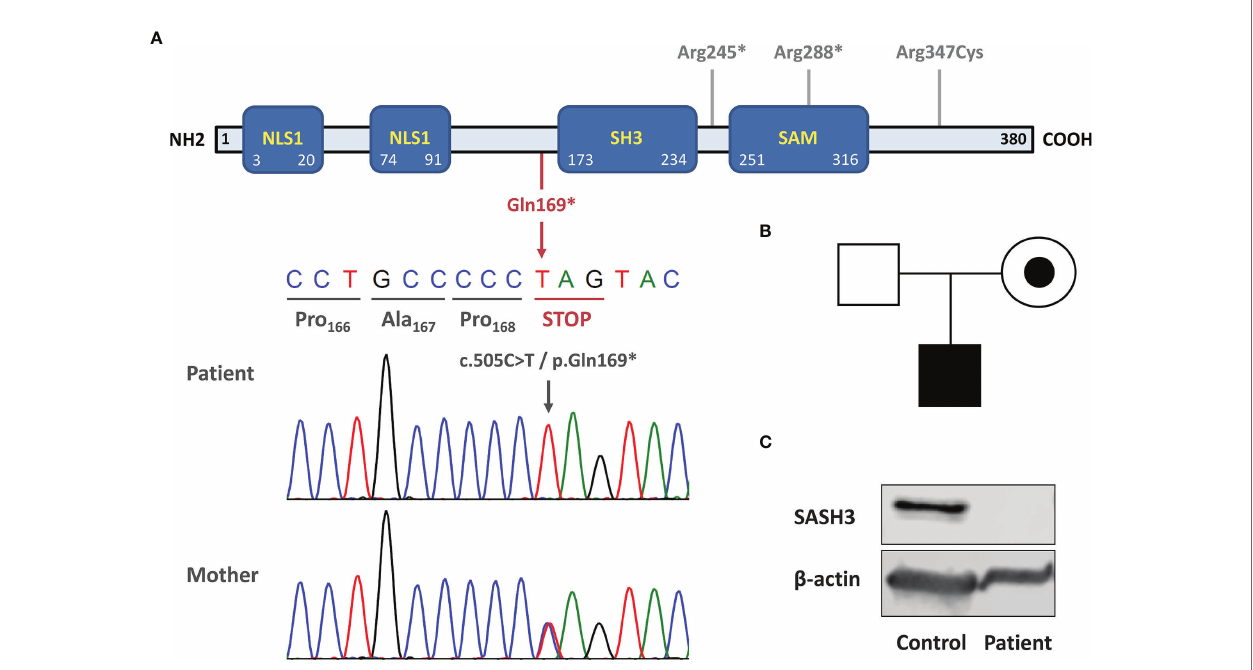
FIGURE 1 | Novel loss-of-function variant causing SASH3 de fi ciency. (A) Schematic structure of SASH3 protein. The location of the c.505C>T/p.Gln169* variant is indicated below in red and Sanger sequencing con fi rmation is shown. The three other variants reported by Delmonte et al. are indicated in gray in the upper part. (B) Pedigree and familial segregation of the SASH3 variant. The patient was hemizygous and his mother, a heterozygous carrier. (C) Western blot showing absence of SASH3 protein in patient PBMCs. The immunogen recognized by the antibody used (SASH3 polyclonal antibody #PA5-70305, Termo fi sher Scienti fi c) is located at the N-terminal region of human SASH3 protein, before the amino acid 169 (where the STOP codon is